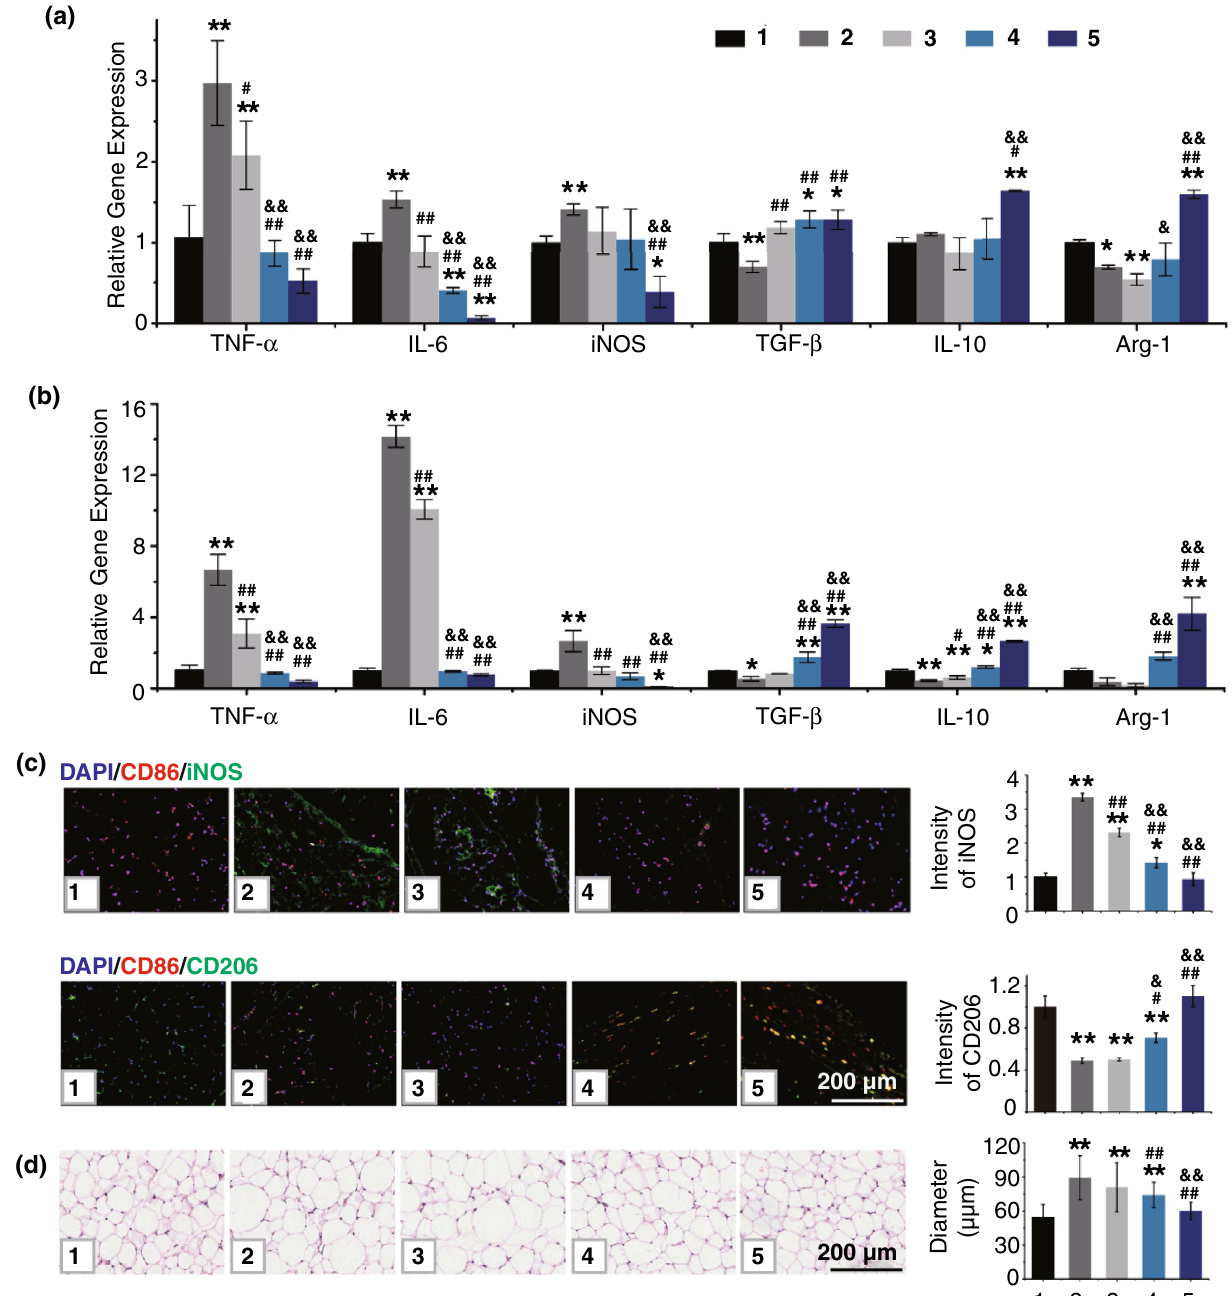
Fig. 3 tFNAs-RSV induced M2 macrophages polarization in adipose tissue. a Quantitative RT-PCR analysis of the expression of TNF-α , IL-6 , iNOS , TGF-β , IL-10 , and Arg-1 in epididymal fat tissue. b Quantitative RT-PCR analysis of the expression of TNF-α , IL-6 , iNOS , TGF-β , IL- 10 , and Arg-1 in inguinal fat tissue. c Tissue immunofluorescence staining of CD68, iNOS, or CD206 and quantitative analysis of the relative fluorescence intensity of iNOS or CD206; d H&E staining of inguinal fat tissue and analysis of the diameters of adipocytes. Scale bars: 200 μm. Data were performed using one-way analysis of variance (ANOVA) and presented as mean ± SD ( n ≥ 3). Statistical analysis: *Compare with the control group, * P < 0.05, ** P < 0.01; # Compare with the LPS and IFN-γ group, # P < 0.05, ## P < 0.01; & Compare with the control group, & P < 0.05, && P <